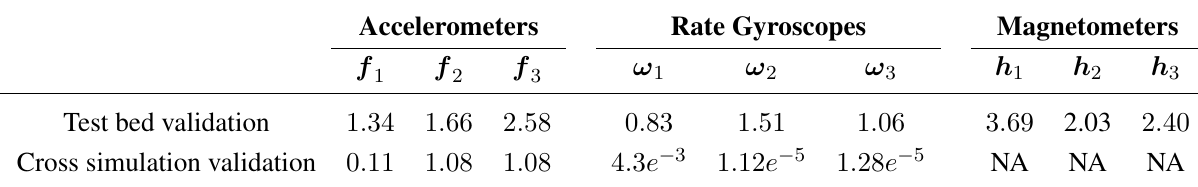
Table 3. Normalized root mean square error (NRMSE) of the error from all of the different validations. All data are given as the percentage of the full scale. Accelerometers